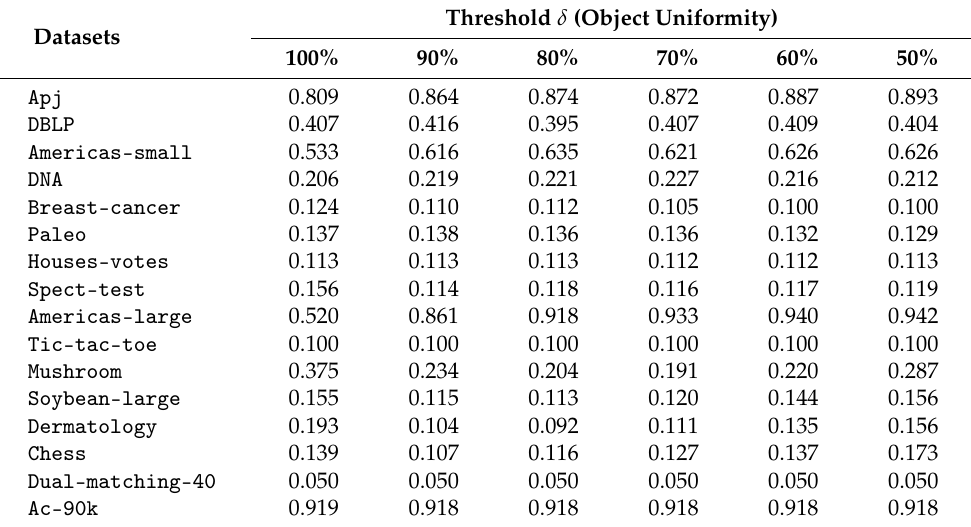
Table 14. The object uniformity metric of the C ONCISE algorithm with different